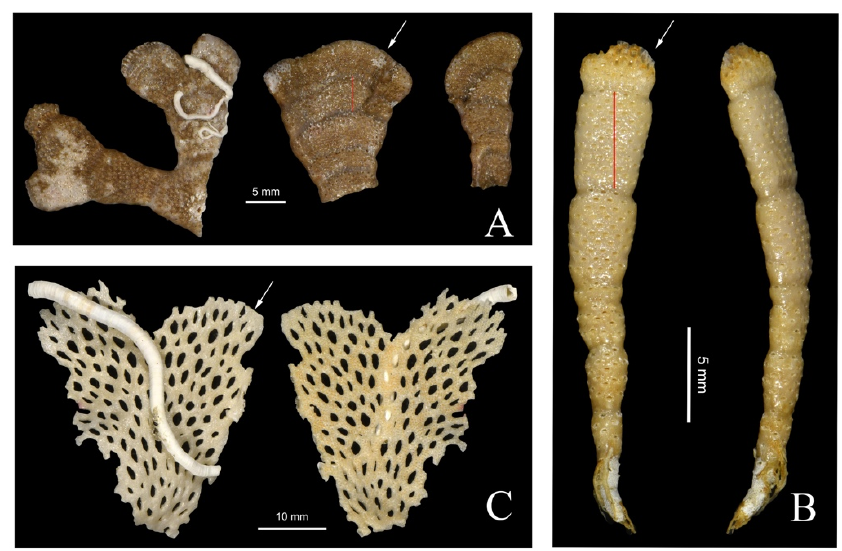
Figure 3. Images of live study material: ( A ) Cellarinella nutti ; ( B ) Cellarinella njegovanae ; ( C ) Reteporella frigida . Arrows show the growing edges (distal part of the colony). Red lines show the annual growth band between two growth checks.